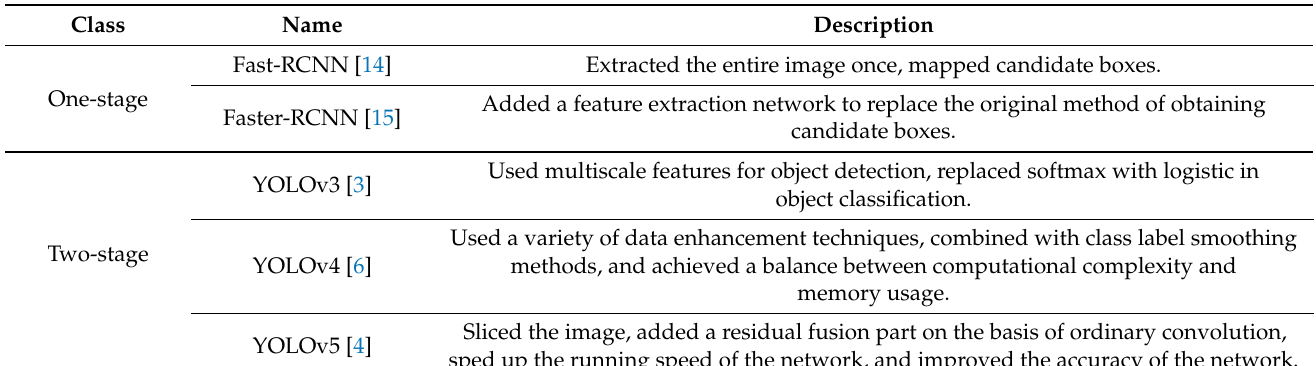
Table 2. The description of one-stage and two-stage obstacle detection methods.